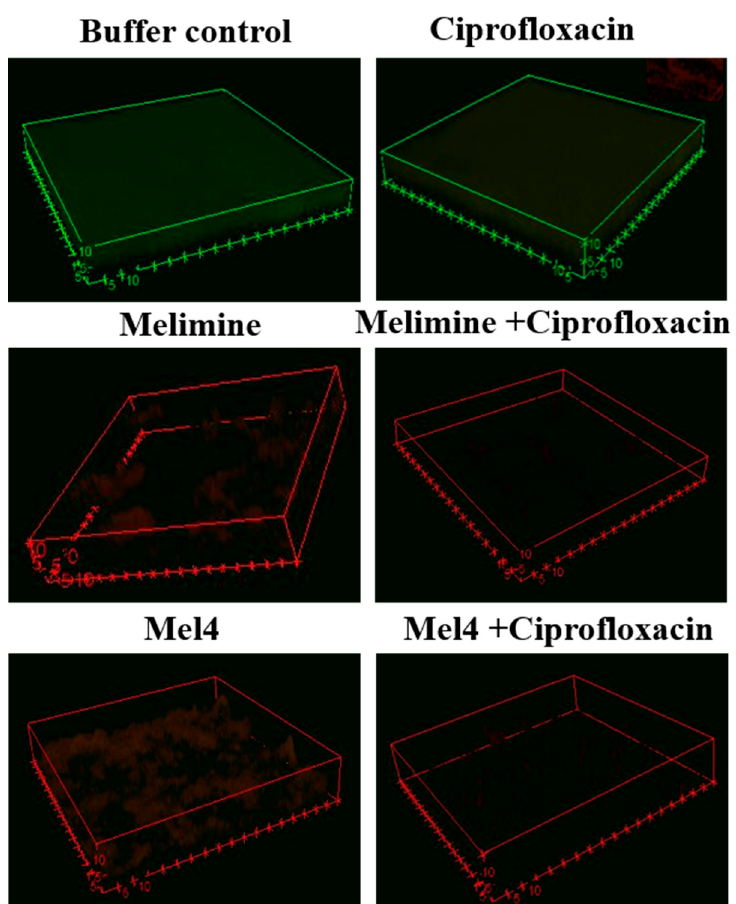
Figure 5. Representative confocal laser scanning microscopy images of biofilms of the ciprofloxacin- resistant isolate of P. aeruginosa ATCC 27853 after treatment with AMPs and ciprofloxacin alone or in combination. The antibiofilm effects were evaluated at 4× the MIC of all antimicrobials after incubation for 24 h. The biofilms of P. aeruginosa were stained with SYTO-9 (excited at 488 nm, green live cells) and propidium iodide (excited at 514 nm, red dead cells). The cells exposed to ciprofloxacin alone